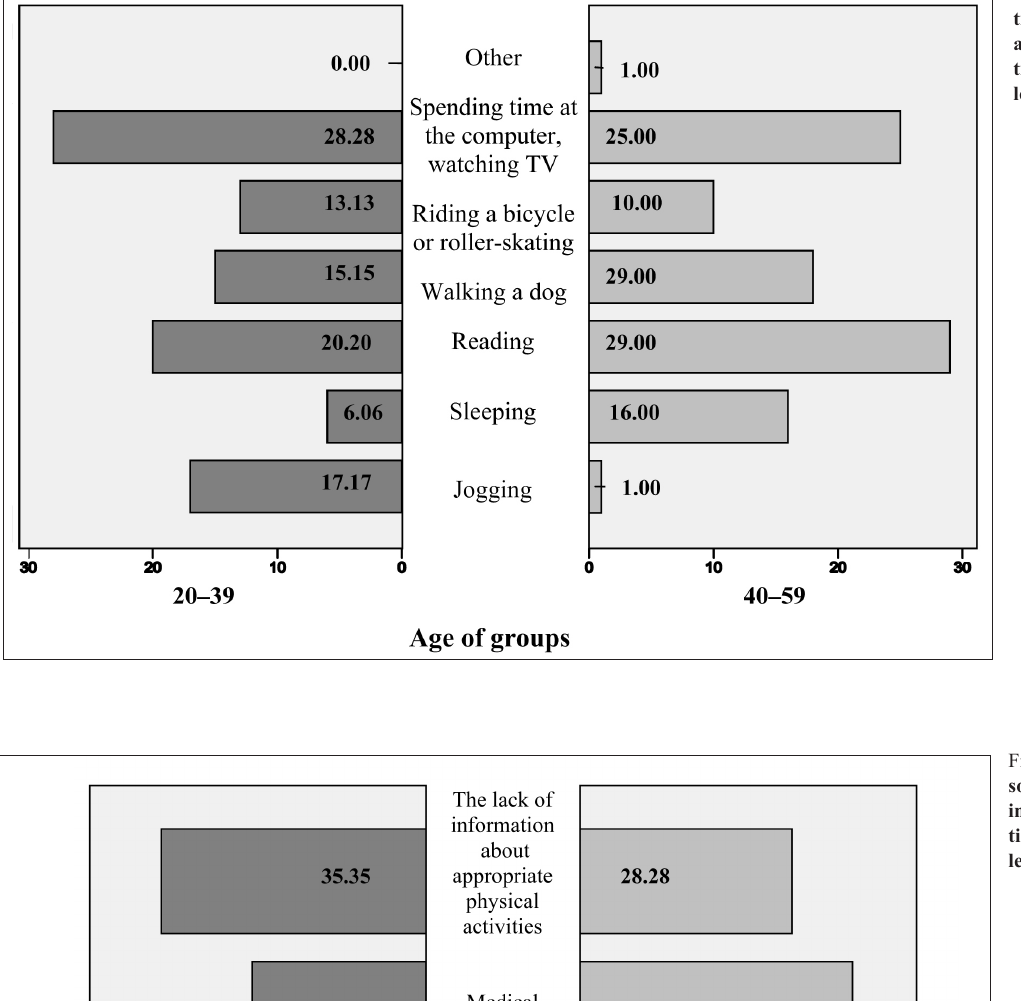
Figure 2. Leisure time physical activities of pa-